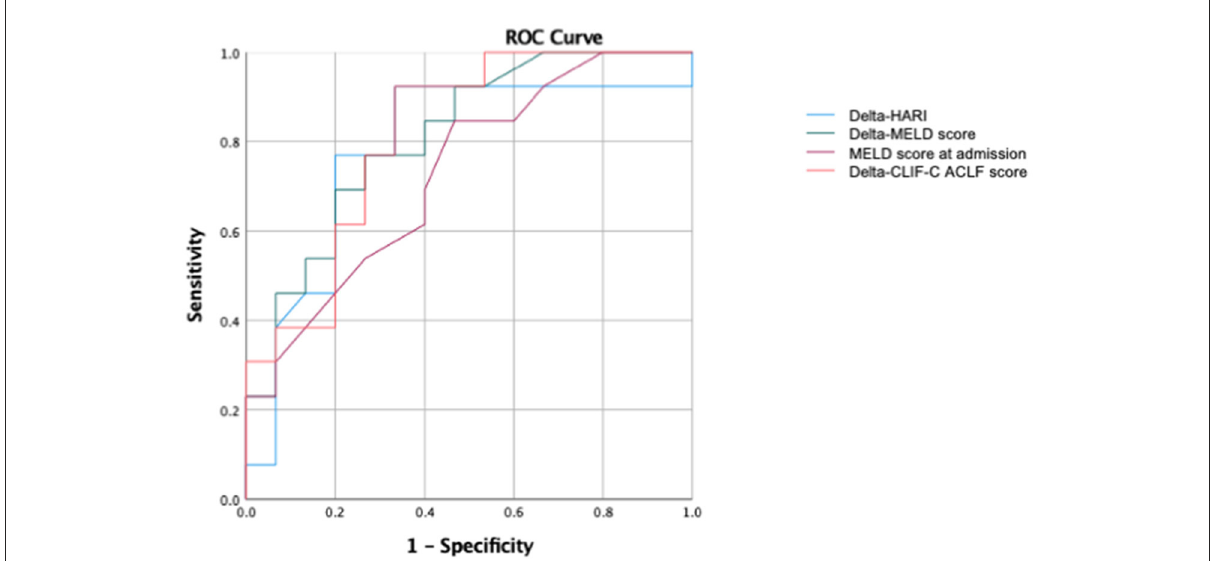
FIGURE7 Subgroup ROC analysis for patients with liver cirrhosis of the prediction of ICU mortality. AUC of delta-HARI was 0.78 (95% Confidence Interval: 0.60–0.97, p = 0.011), AUC of delta-MELD was 0.81 (95% Confidence Interval: 0.65–0.97, p = 0.005), AUC of MELD-Score at admission was 0.73 (95% Confidence Interval: 0.54–0.914, p = 0.040), and AUC of delta-CLIF-C-ACLF was 0.815 (95% Confidence Interval: 0.66–0.97, p =